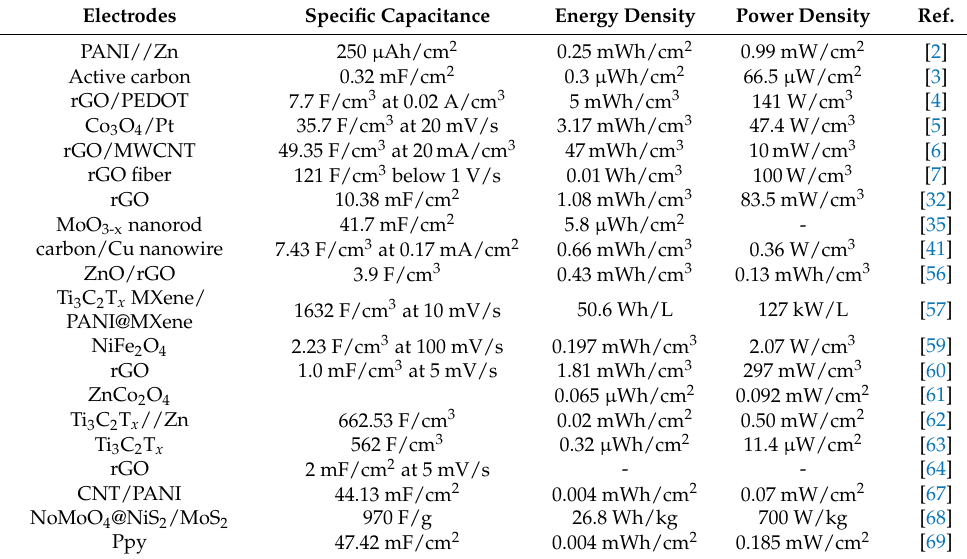
Table 1. Summary of flexible MSCs with different electrode materials and their electrochemical